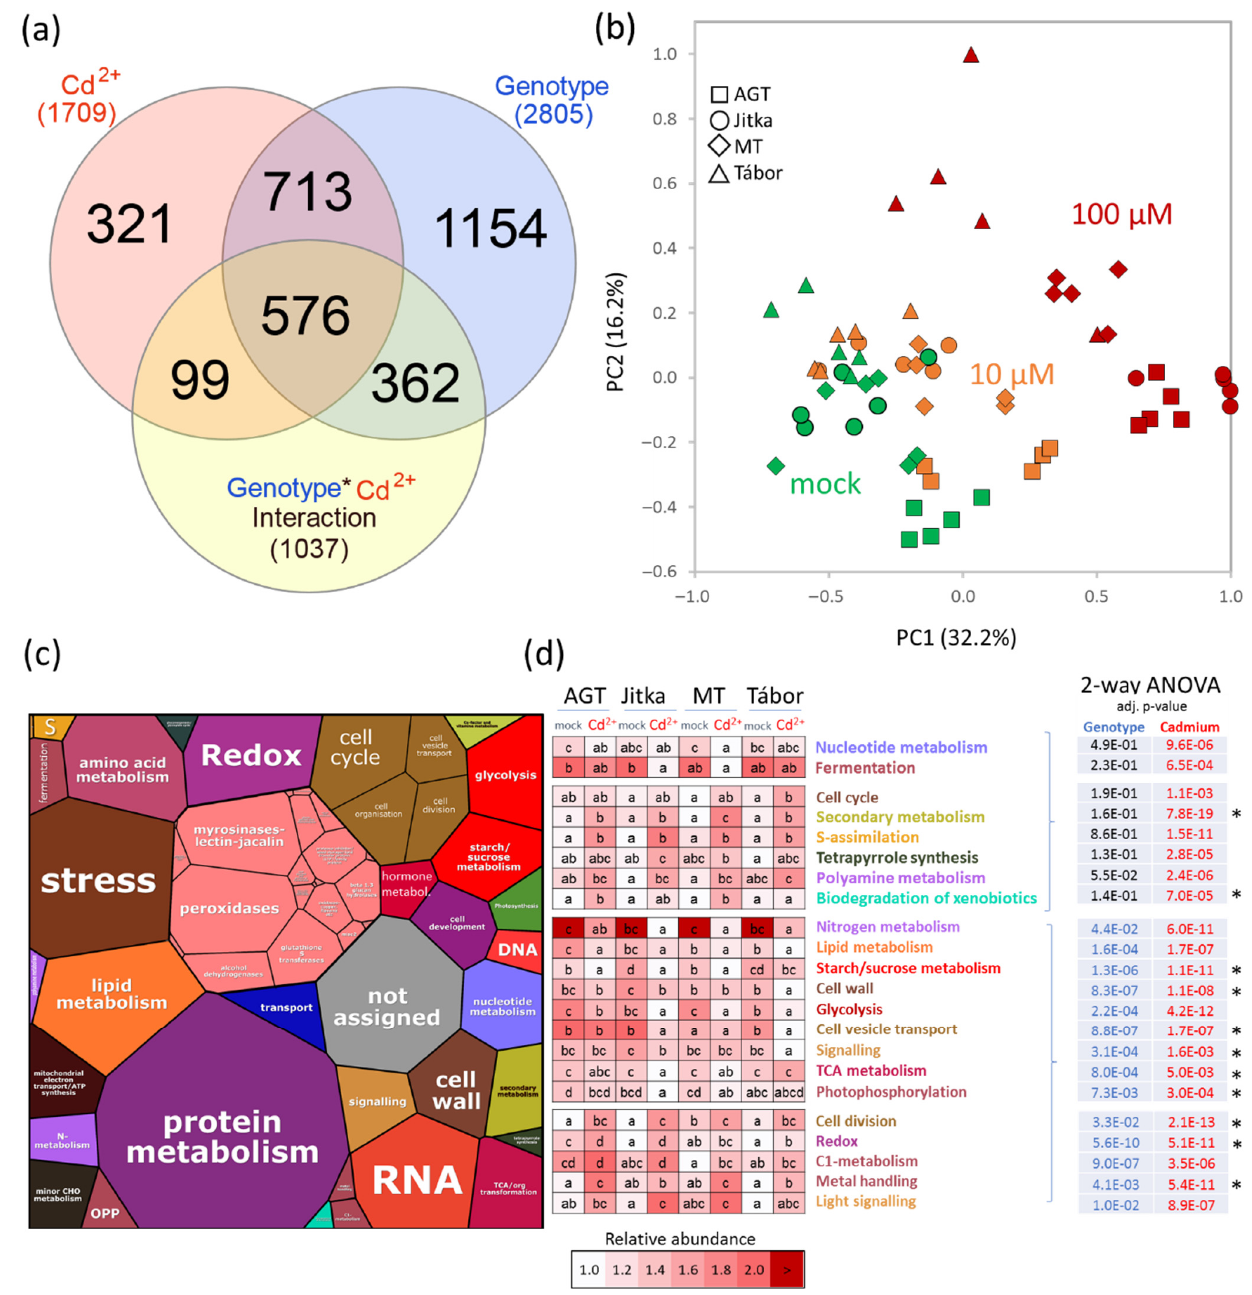
Figure 4. Cadmium response in root tissue of four different genotypes. Comparison of mock-treated roots and response to 100 µM Cd 2+ . ( a ) Results of the two-way ANOVA analysis visualized in a Venn diagram, ( b ) PCA based on the profile of 1435 differentially abundant proteins ( p < 0.05, at least 1.5-fold change), ( c ) visualization of functional categories in the ProteoMap, and ( d ) significant differences visualized on a heat map. The ProteoMap corresponds to the estimated content in the mock-treated AGT plants. Asterisks indicate a significant interaction of genotype and cadmium concentration on protein abundances. The letters represent significant differences ( p < 0.05, ANOVA, Tukey’s HSD). For details, see Supplementary Table S3.